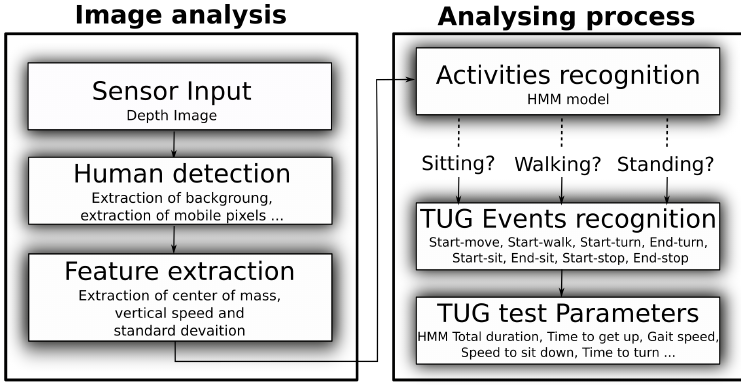
Figure 3. Automatic detection method of the different events of the TUG